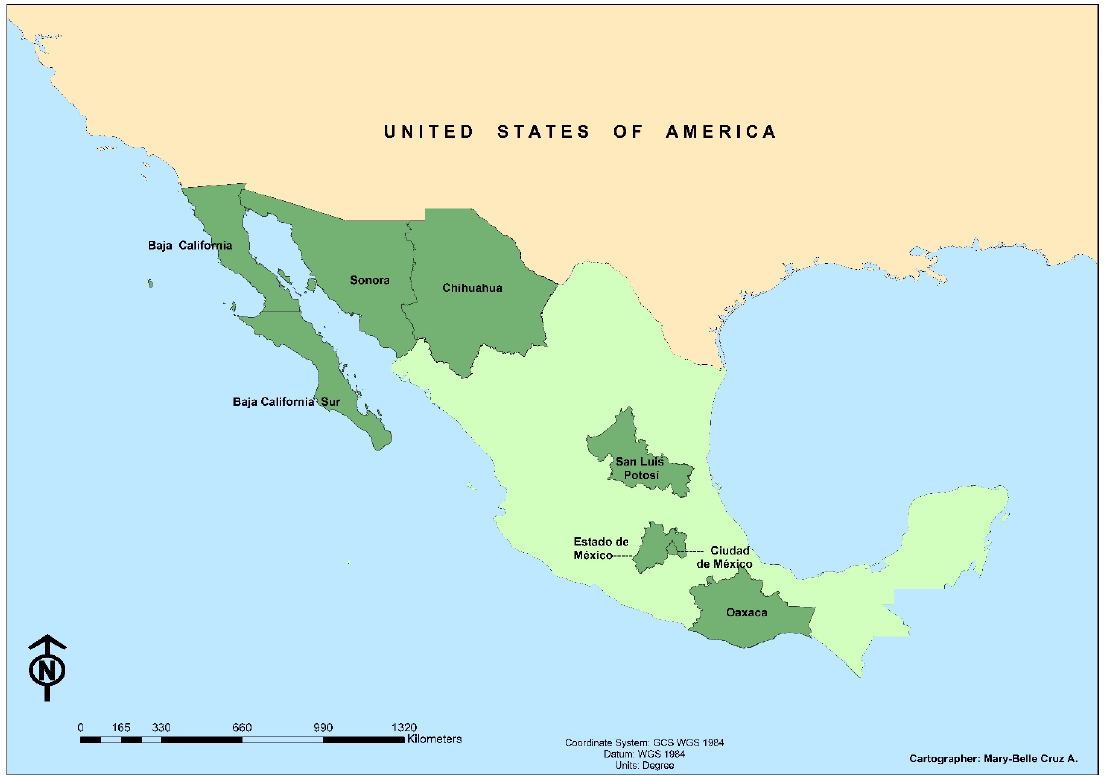
Figure 1. Study sites: Baja California, Baja California Sur, Ciudad de Mexico, Chihuahua, Estado de Mexico, Oaxaca, Sonora, and San Luis Potosí